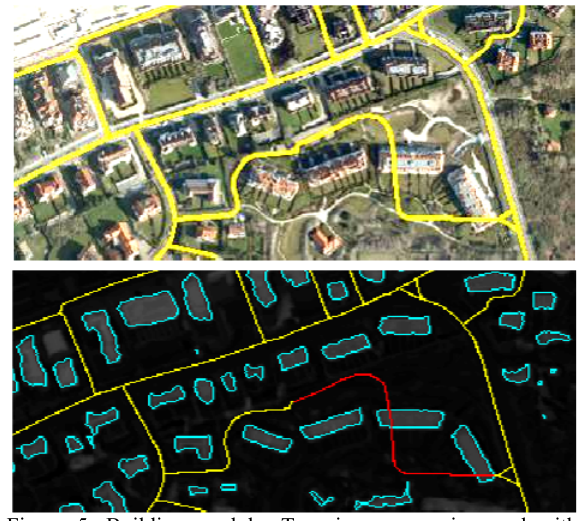
Figure 5: Building module. Top: image superimposed with database roads containing one incorrect object. Bottom: nDSM superimposed with extracted red, no decision = yellow)